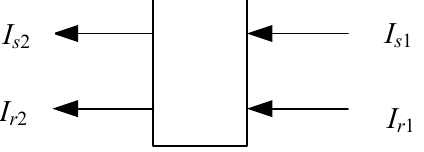
Figure 1. Schematic diagram of two beams passing through a cuvette with width l